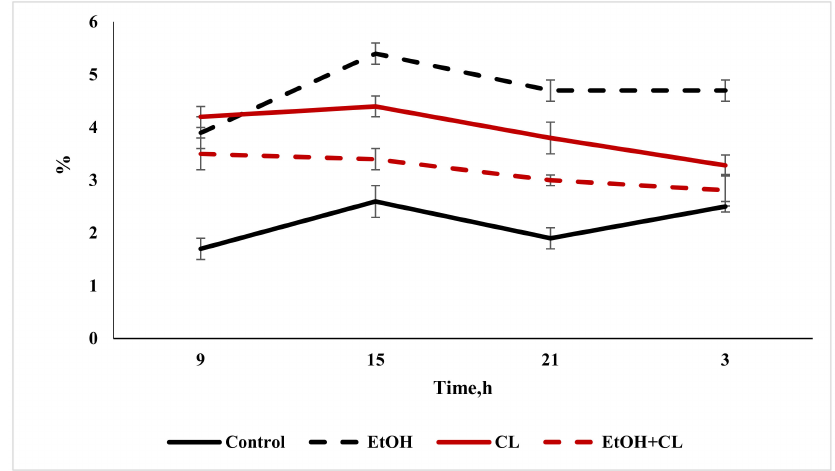
Figure 18. Daily fluctuations in the expression of p53 in rat